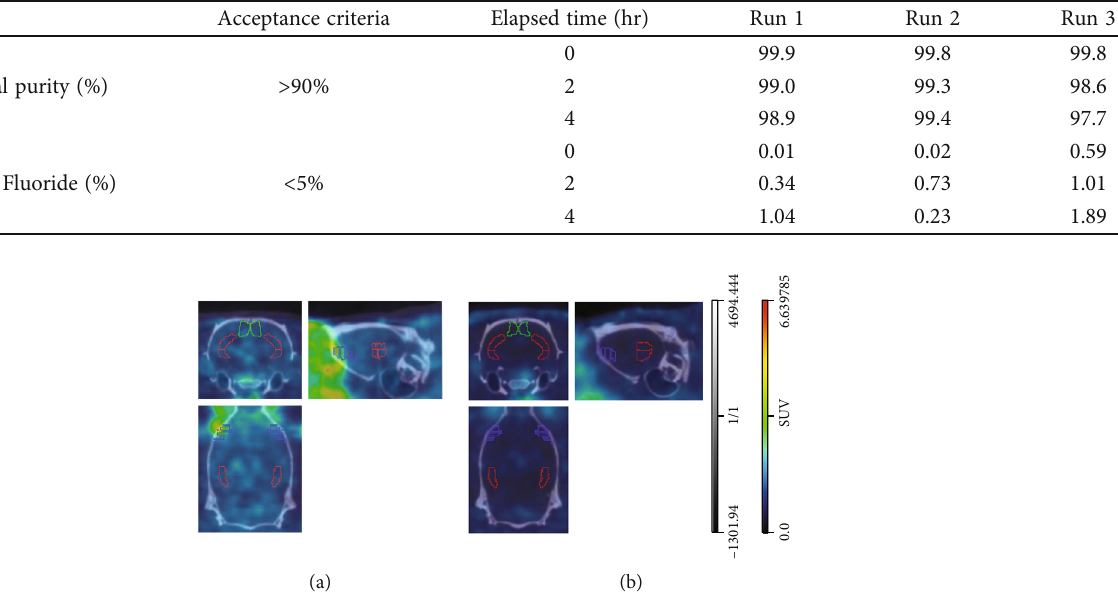
Figure 2: Representative imaging of coronal, sagittal, and axial sections of rat brain exposed to ambient PM2.5 ((a) PM2.5, left panel) versus fi ltered air ((b) FL, right Table 3: MicroPET Imaging of the [ 18 F]FEPPA (2) in ambient